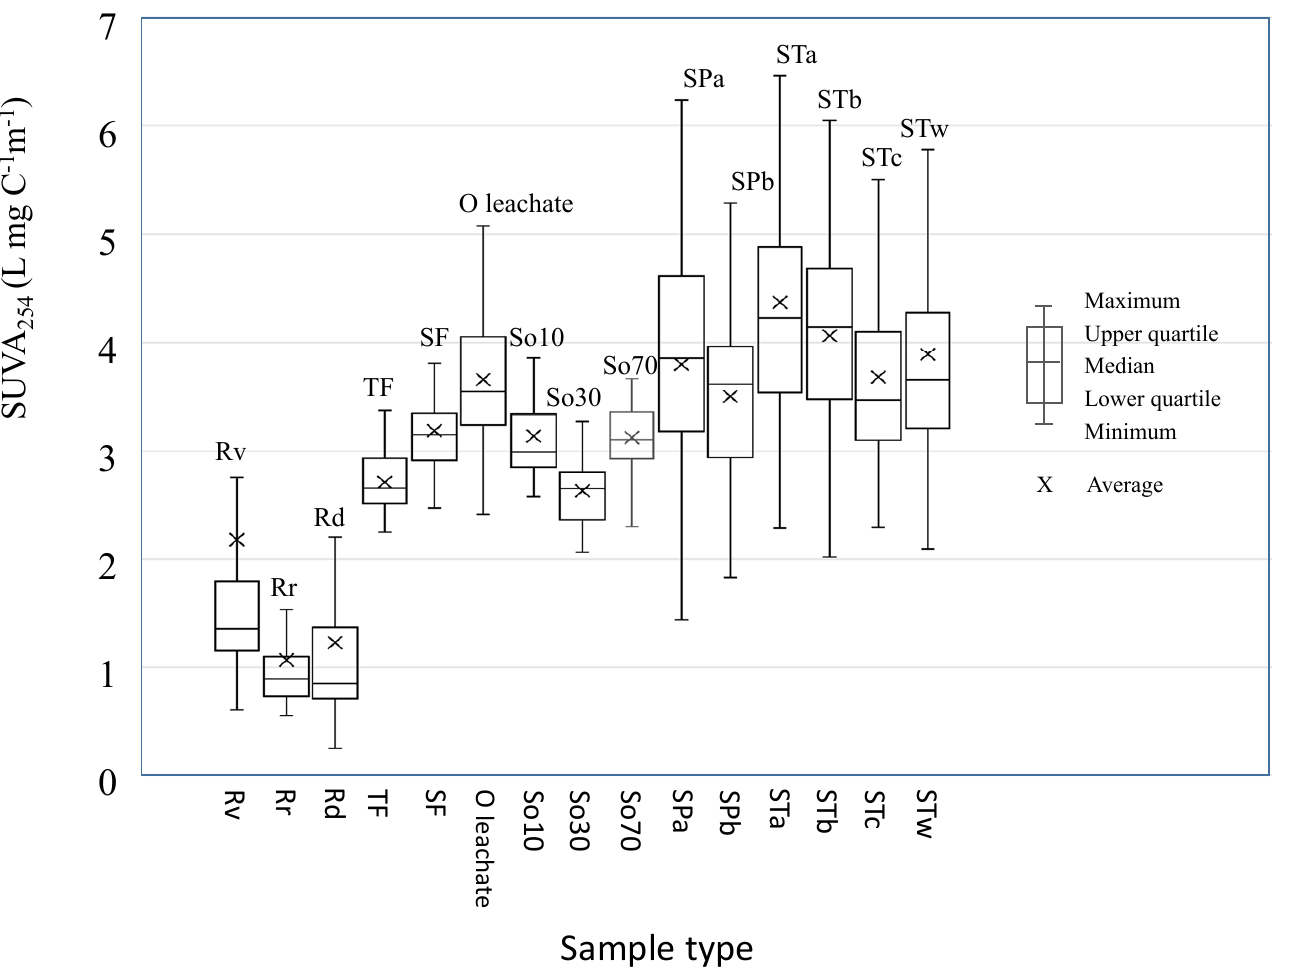
Figure 7. Comparison of SUVA 254 among sample types in the watershed. See Figure 1 for the meaning of the